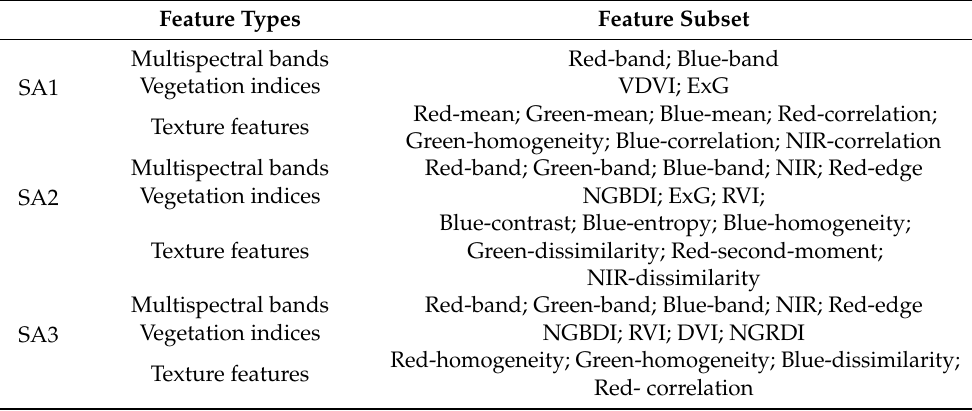
Table 6. List of screening results of feature